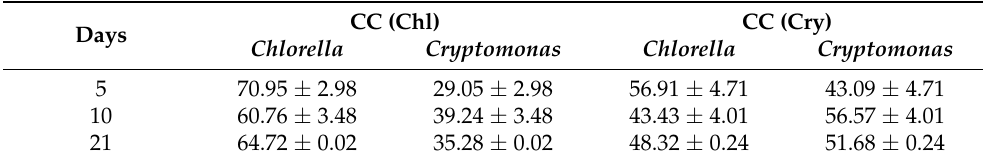
Table 7. Estimation (M ± SD, %) of the diet of Daphnia galeata by the QFASA model using dietary subset of FAs (16:2n-6, 16:2n-4, 16:3n-3, 16:4n-3, 18:2n-6, 18:3n-3, 18:4n-3, 18:5n-3,